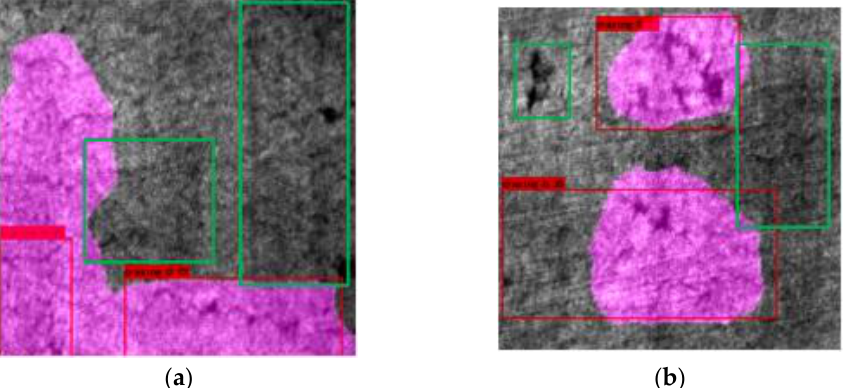
Figure 7. Failure analysis. ( a , b ) show failed predictions. The green boxes in the figure are unde- tected defects.